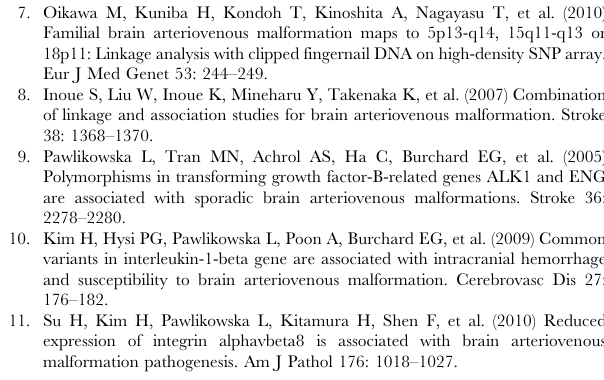
Figure S1 CNVs called by PennCNV that mapped to